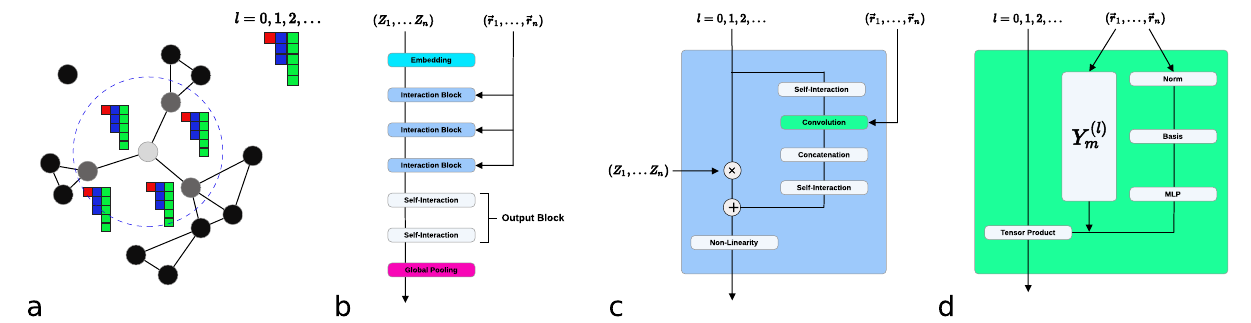
Fig. 1 The NequIP network architecture. From left to right: ( a ) a set of atoms is interpreted as an atomic graph with local neighborhoods ( b ) atomic numbers are embedded into l = 0 features, which are re fi ned through a series of interaction blocks, creating scalar and higher-order tensor features. An output block then generates atomic energies, which are pooled to give the total predicted energy. c The interaction block, containing the convolution. d The convolution combines the product of the radial function R ( r ) and the spherical harmonic projection of the unit vector ^ r ij with neighbouring features via a